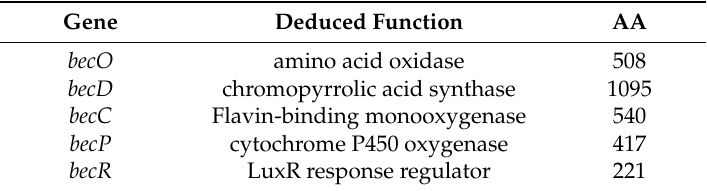
Table 2. Deduced functions of open reading frames (ORFs) in BE-13793C ( bec) in the Streptomyces sp. MA37 biosynthetic gene